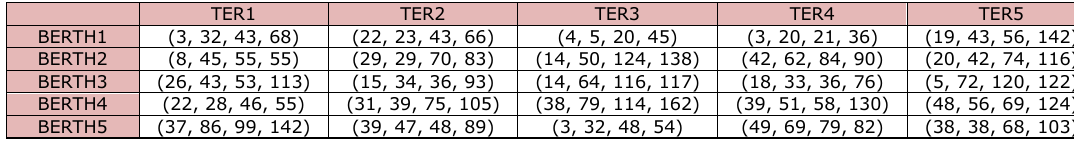
Table 4. “Distance between Berth b and Terminal area j for NI containers”.